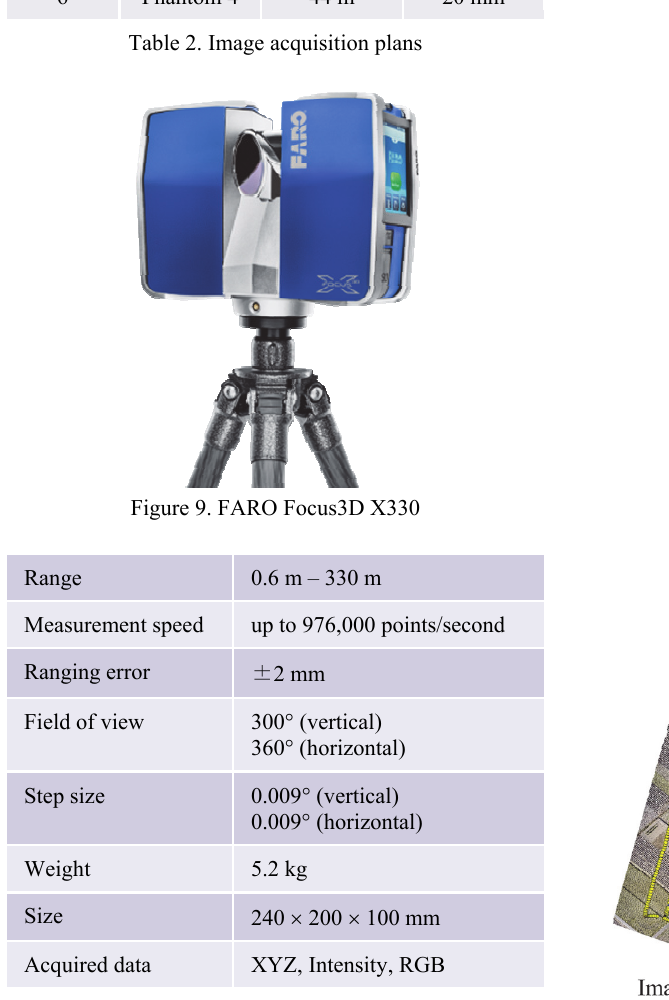
Table 3. Specification of FARO Focus3D X330